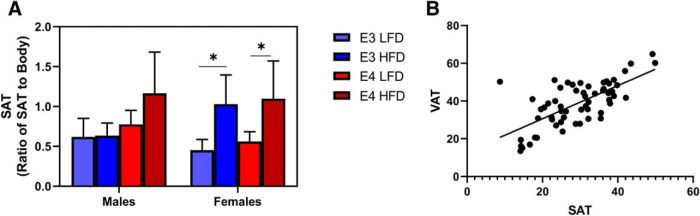
HFD increases SAT in APOE3 and APOE4 mice. Within sex and across sex quantification of VAT in APOE3 and APOE4 mice (A). Correlation of VAT and SAT accumulation (B). A, N = 5–9, *p < 0.04, three-way ANOVA Tukey’s multiple comparison test. B, N = 59, linear regression R
2 = 0.47, p ≤ 0.0001.